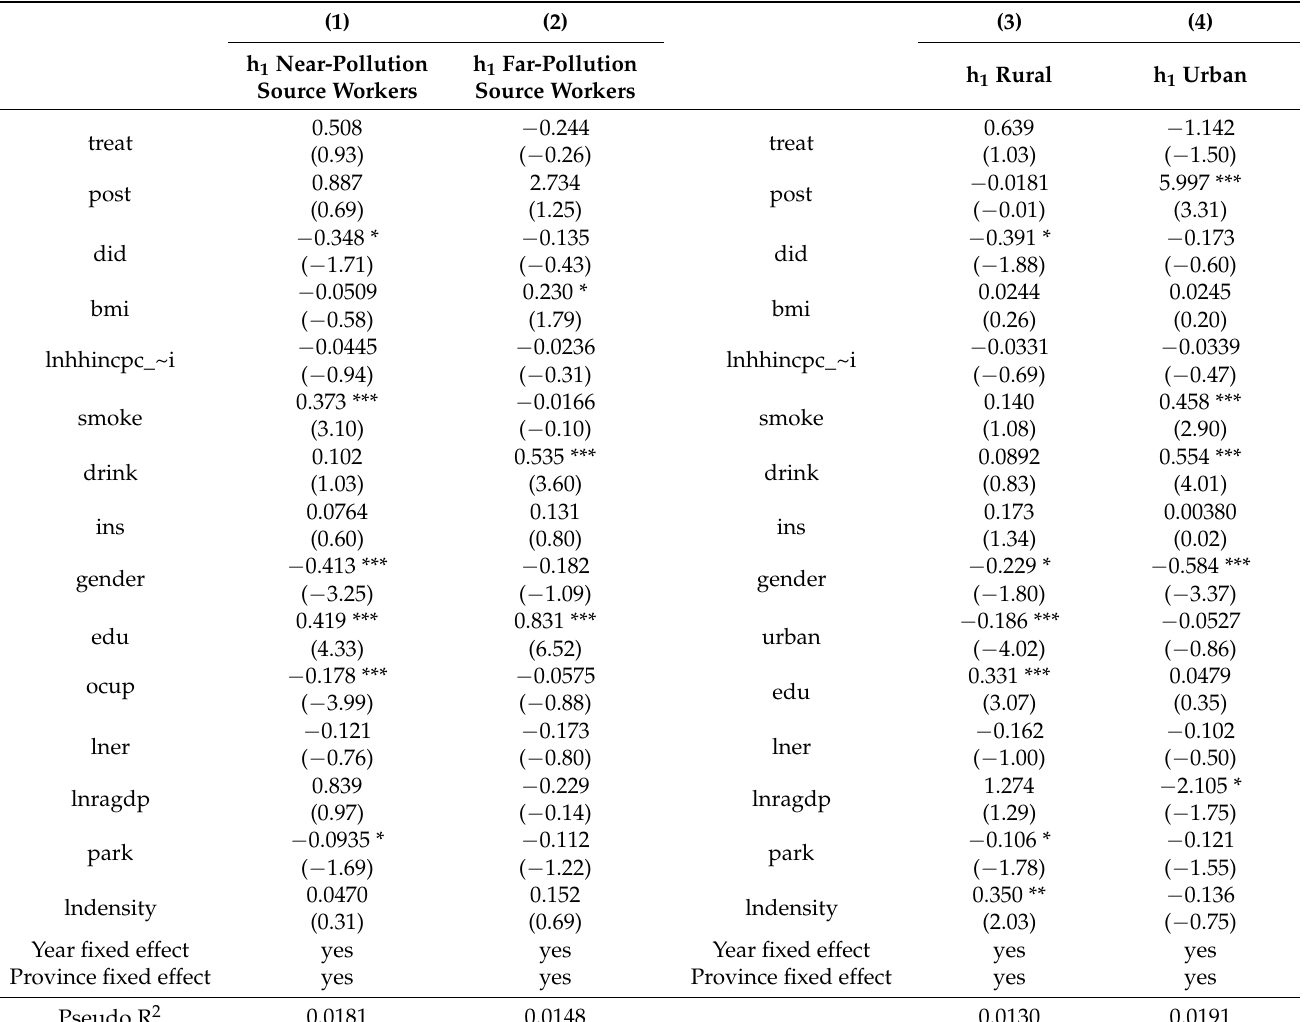
Table 5. Heterogeneity